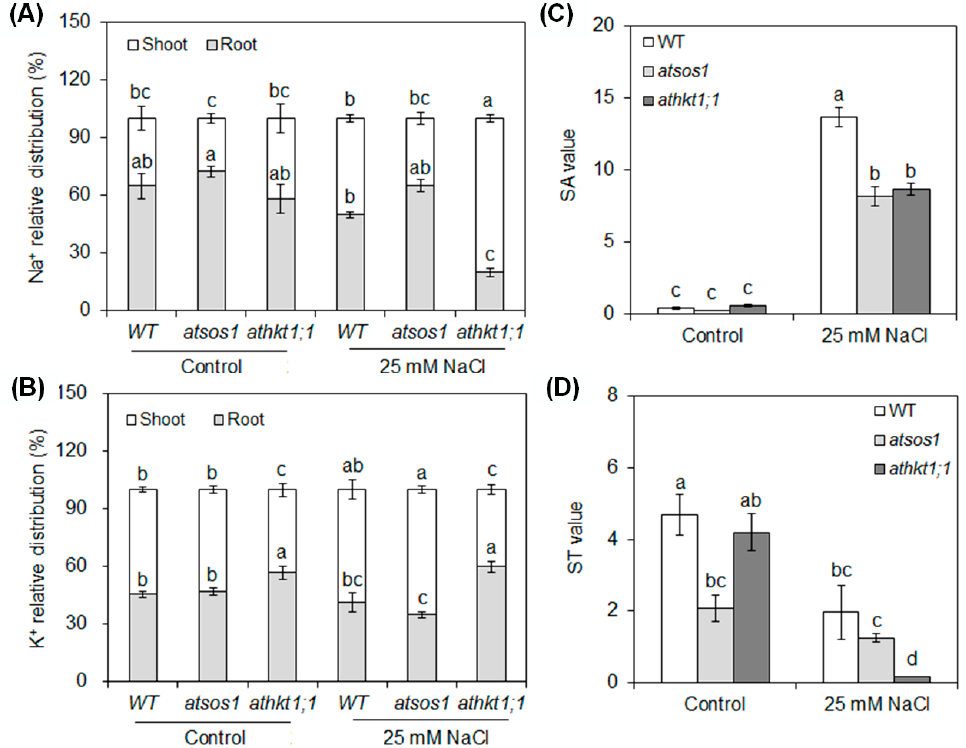
Figure 2. Relative distribution of Na + ( A ) and K + ( B ) in tissues and net selective absorption ( C ) and transport ( D ) capacity for K + over Na + from the roots to the shoots (SA and ST value, respectively) in 6-week-old WT, atsos1 , and athkt1;1 with or without 25 mM NaCl for 4 d. Values are means ± SE ( n = 8), and bars indicate SE. Columns with different letters indicate significant differences at p < 0.05 (Duncan’s test).